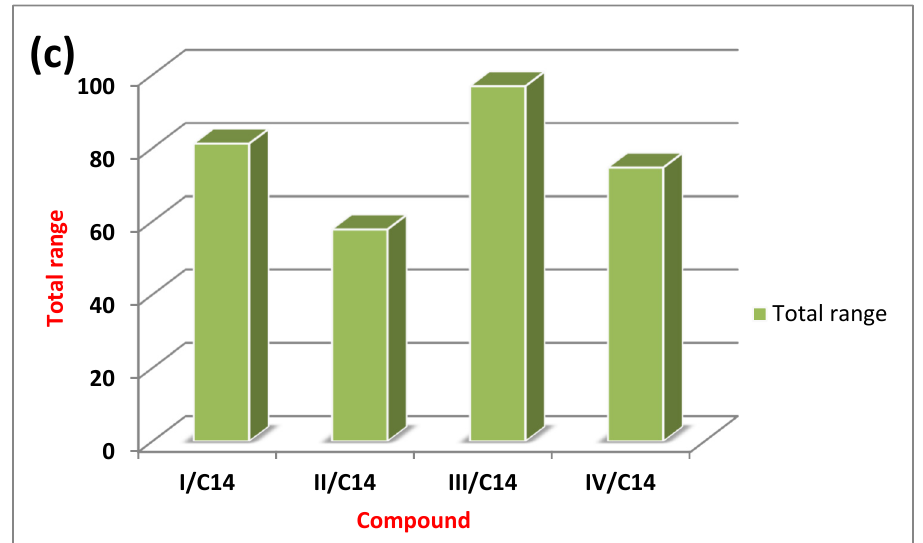
Figure 5. The relation between the type of the polar group and nematic ( a ), smectic ( b ) and total ( c ) mesophase range of the investigated compounds (I-IV)C14